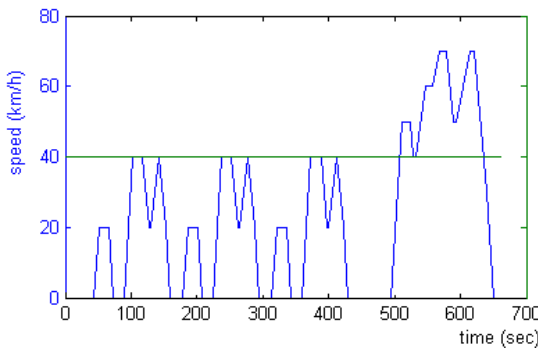
Figure 7. Speed profile of the CYC-1015 drive